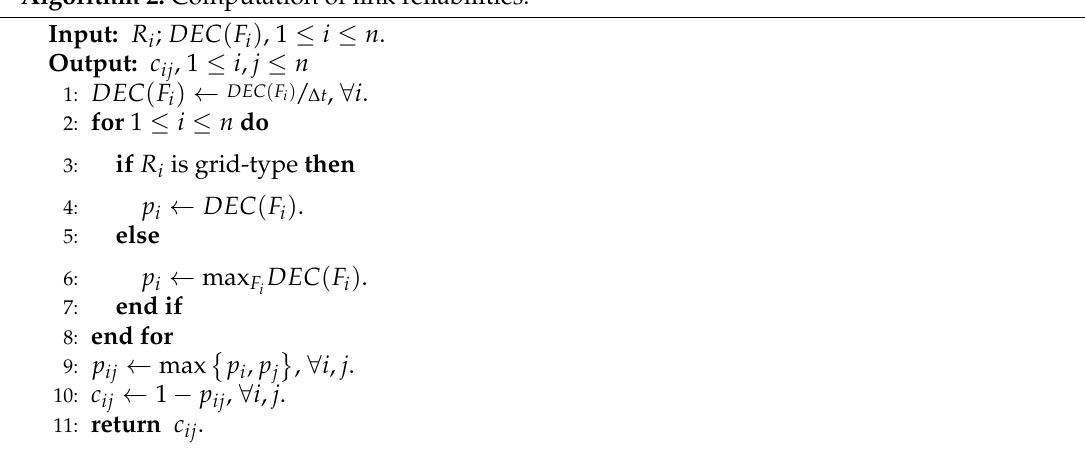
Algorithm 2: Computation of link